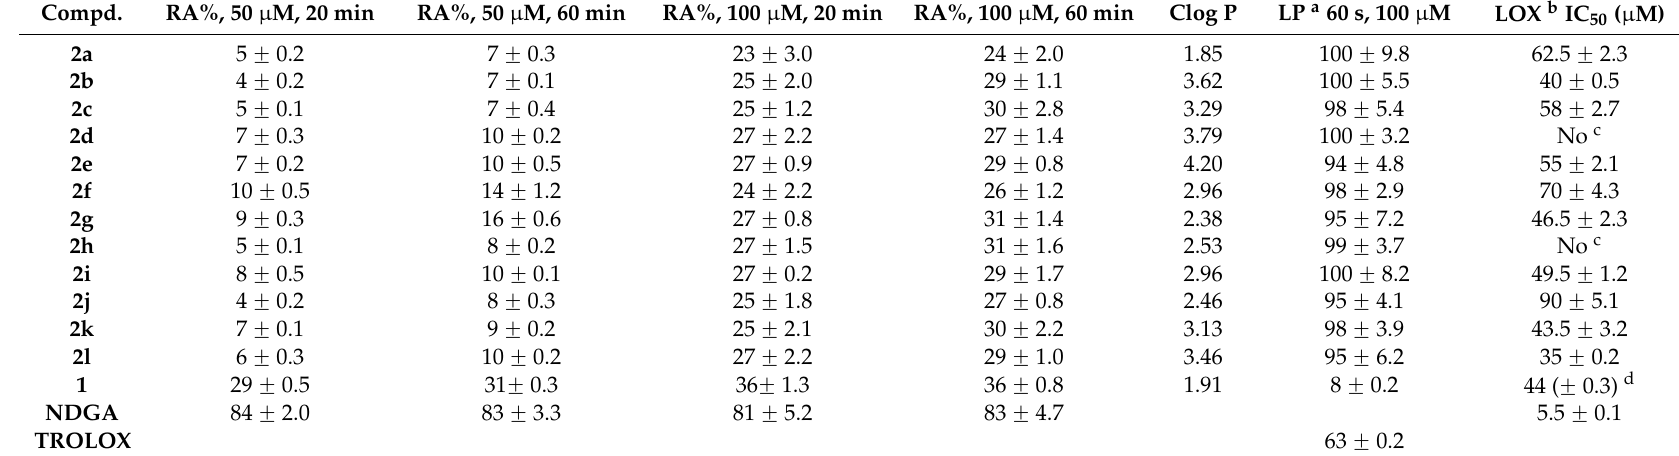
Table 1. Inhibition % of DPPH at different concentrations and times, calculated lipophilicity Clog P [41] and % inhibition of LP and (LOX) (IC 50 ) for compound 2 .